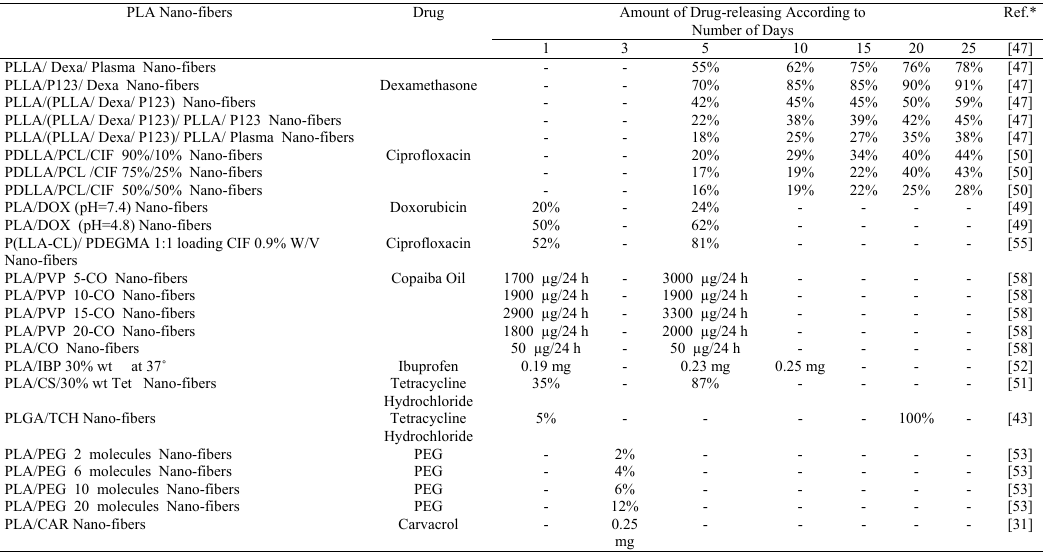
Table 1. Drug-release Studies of PLA Drug loaded PLA Nano-fibers